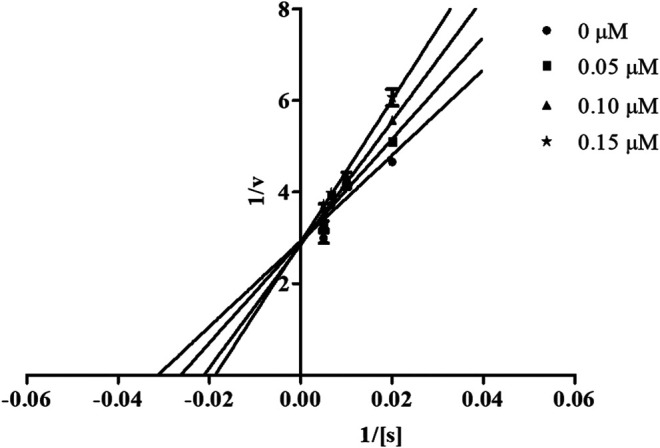
Lineweaver-Burk Plot for h-NTPDase2 inhibitor (8j) S represents the substrate concentration (μM) and concentration of inhibitor (8j) are 0, 0.05, 0.10, and 0.15 μM.